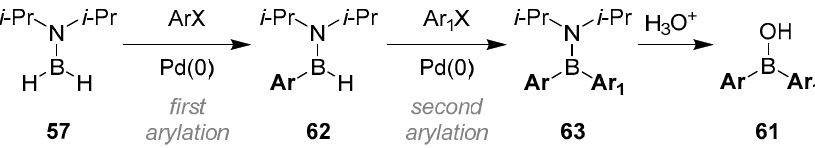
Figure 3. Proposed mechanism of the Pd-catalyzed diarylation of aminoboranes.